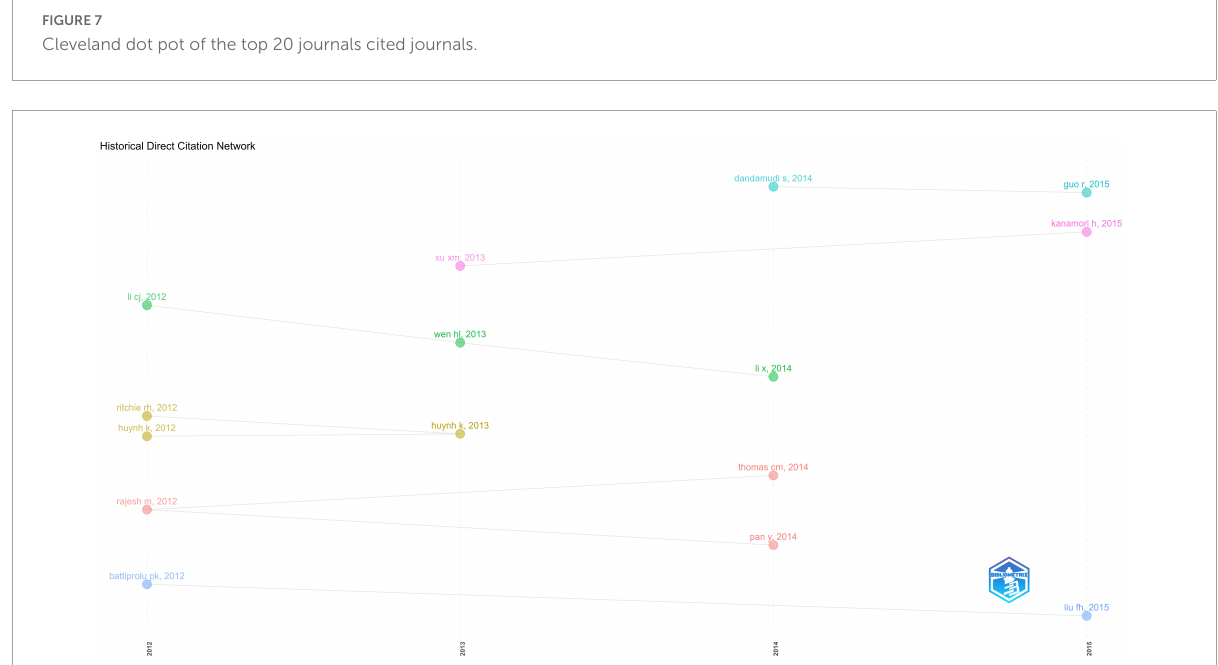
FIGURE8 Historical analysis of direct citation of top-cited articles in DCM field from 2012–2021 generated from R studio Intellectual Structure menu of Biblioshiny